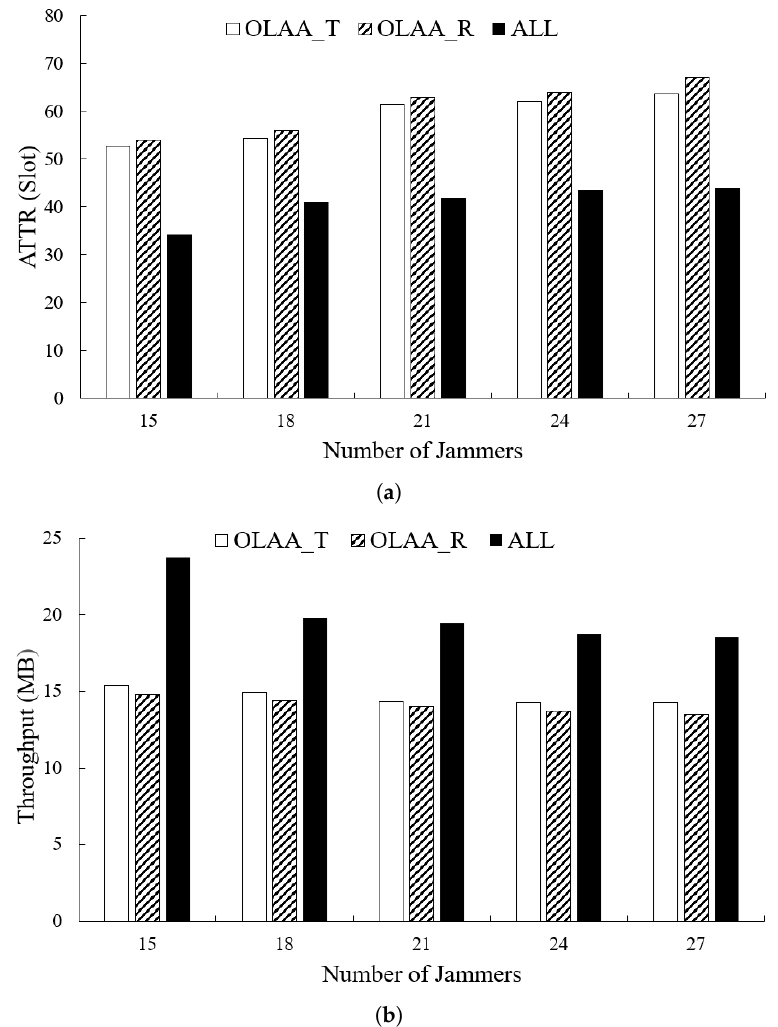
Figure 11. This figure presents the impact of the number of jammers on the performance of